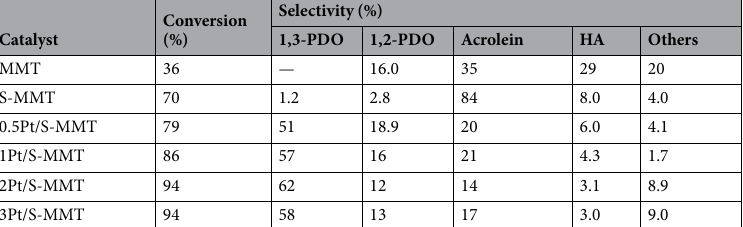
Table 2. Catalytic performance of MMT, S-MMT and 0.5–3 wt% Pt/S-MMT catalysts in glycerol hydrogenolysis a . a Reaction conditions: 10 wt% glycerol aqueous solution; 0.5 g of catalyst; reaction temperature of 200 °C, 1 bar H 2, H 2 flow rate of 70 mL min − 1 ; 1,3-PDO: 1,3-propanediol, 1,2-PDO: 1,2-propanediol, HA: Hydroxyacteone, Others include acetaldehyde, 1-propanol, acetone,